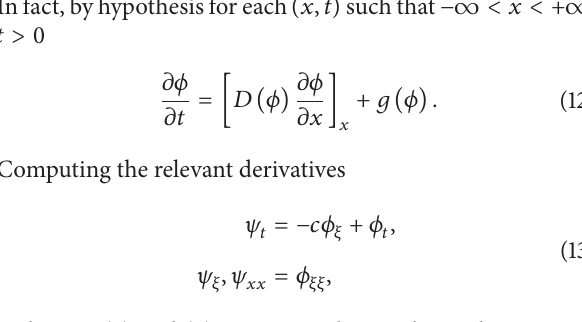
value 𝑢 ≡ 0.5 we compute 𝑥 1 , 𝑥 2 , . . . so that 𝑥 𝑖 is 𝑥 , where ) = 0.5 . We plot this curve versus time and compute 𝑢(𝑥, 𝑡 𝑖 the slope to approximate the wave speed; we have obtained